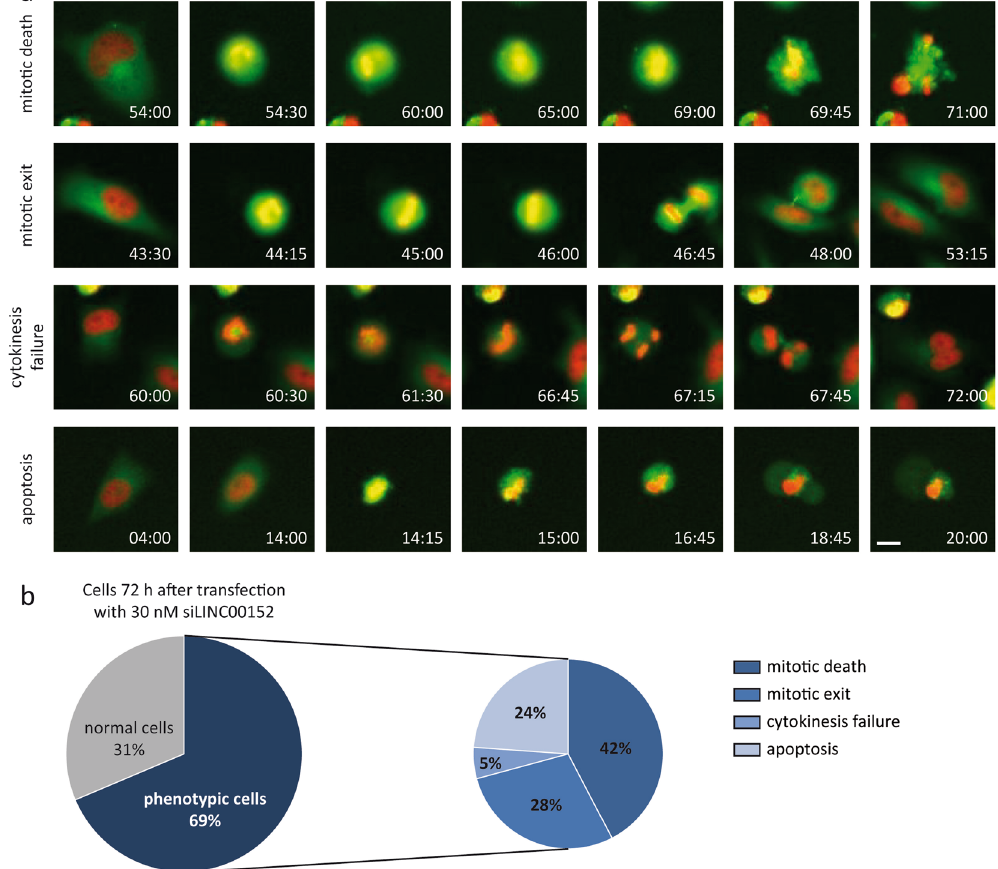
Figure 5. Analysis of cell fates after LINC00152 depletion. ( a ) Images from movies of HeLa cells after LINC00152 knockdown by 30 nM siPOOL showed prometaphase arrest followed by mitotic death, mitotic exit or cytokinesis failure. Some cells also underwent apoptosis at an early stage without prior mitotic arrest. Time depicts hours after transfection. Images were acquired at 20x magnification and scale bar represents 20 μ m. ( b ) Left circle portrays the effect on cells 72 hours after transfection with siLINC00152 (compare with Fig. 4b). Right circle represents a quantification of the cell fates depicted in (A) occurring in phenotypic cells. N =